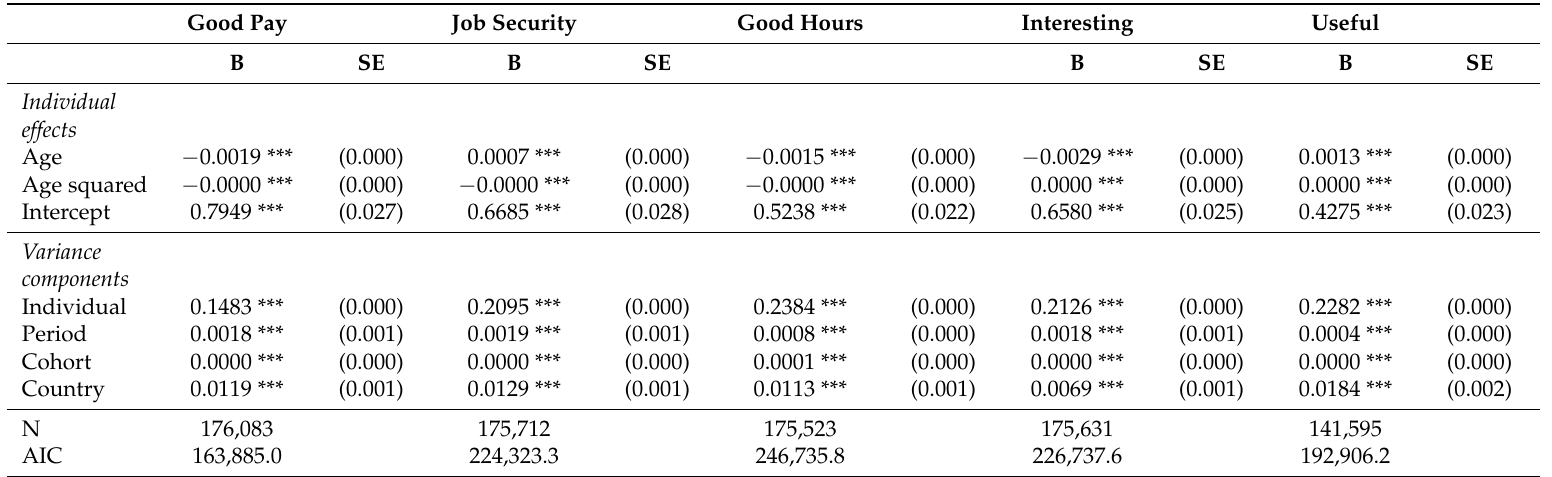
Table A11. The HAPC models of the importance of work values, only time related variables.